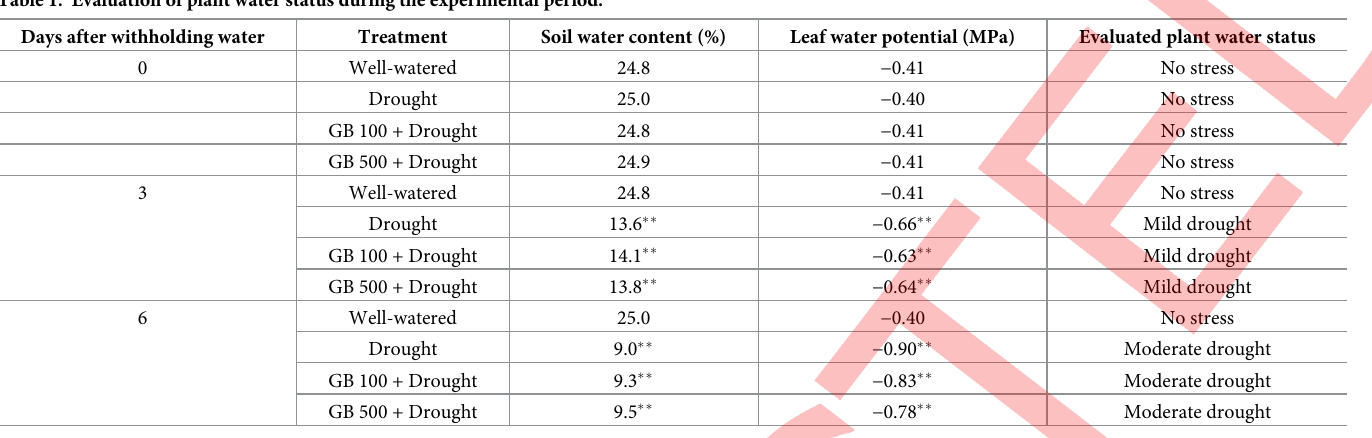
Table 1. Evaluation of plant water status during the experimental period. Days after withholding